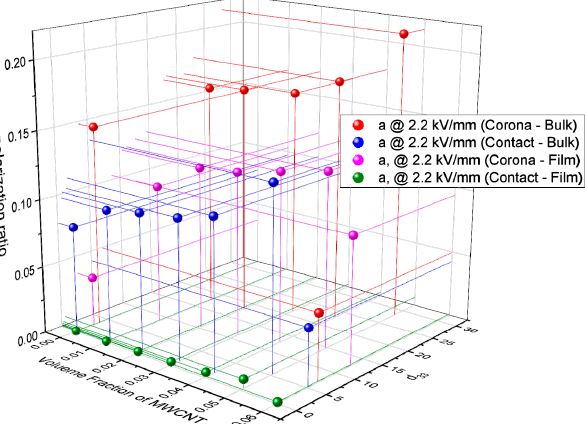
Figure 15. Interrelationship between the polarization ratio for PZT particles as a function of voltage and volume fraction of MWCNTs.